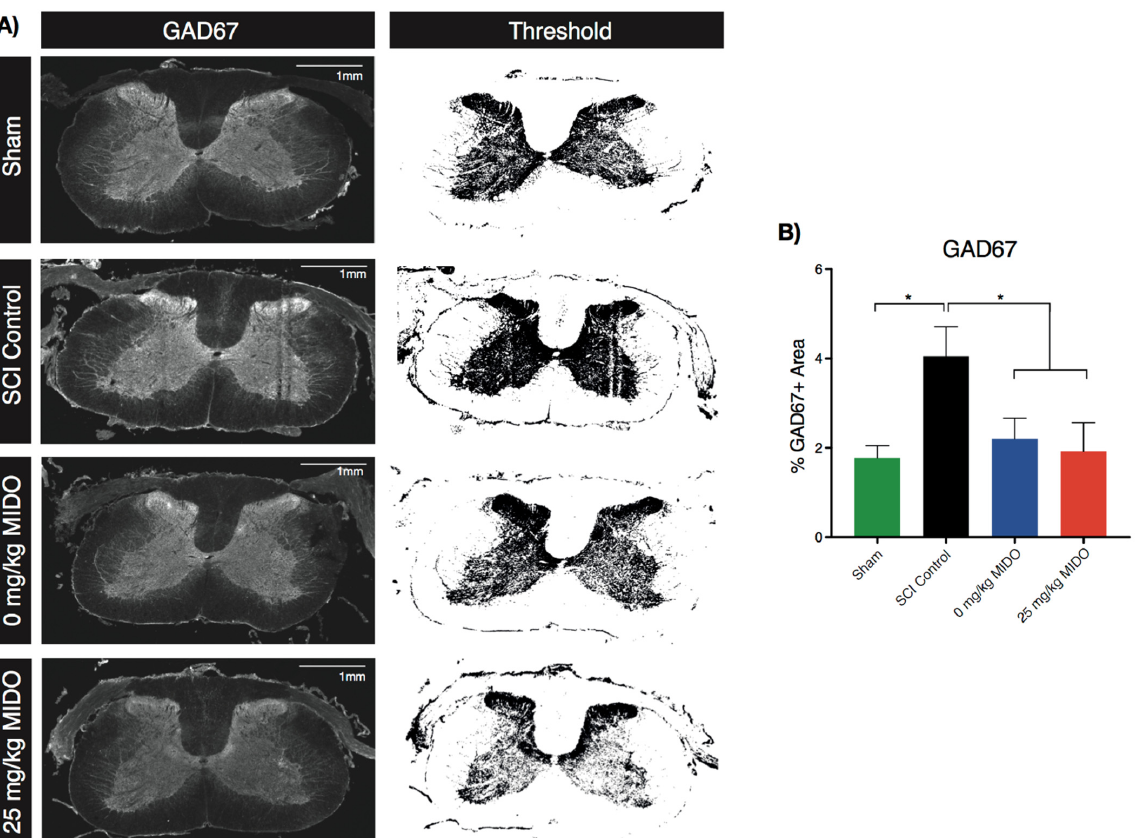
Figure 7. Restored GAD67 availability in treated animals at 960 µm rostral to the C6/7 epicenter. ( A ) Representative GAD67 staining under 2X confocal imaging illustrated in the C6/7 laminectomized sham, SCI control, 0 mg/kg midostau- rin, and 25 mg/kg midostaurin cohorts. ( B ) GAD67 quantification suggested a significant increase in the availability of GAD67 after injury. GAD67 returned to the normal stage in both the 0 mg/kg midostaurin and 25 mg/kg midostaurin cohorts. Data are presented as mean ± SEM values and were assessed using one-way ANOVA using Holm–Sidak for multiple comparisons. *: p < 0.05.